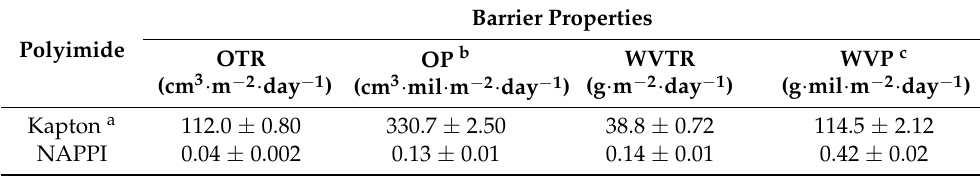
Table 2. Barrier properties of Kapton and NAPPI.